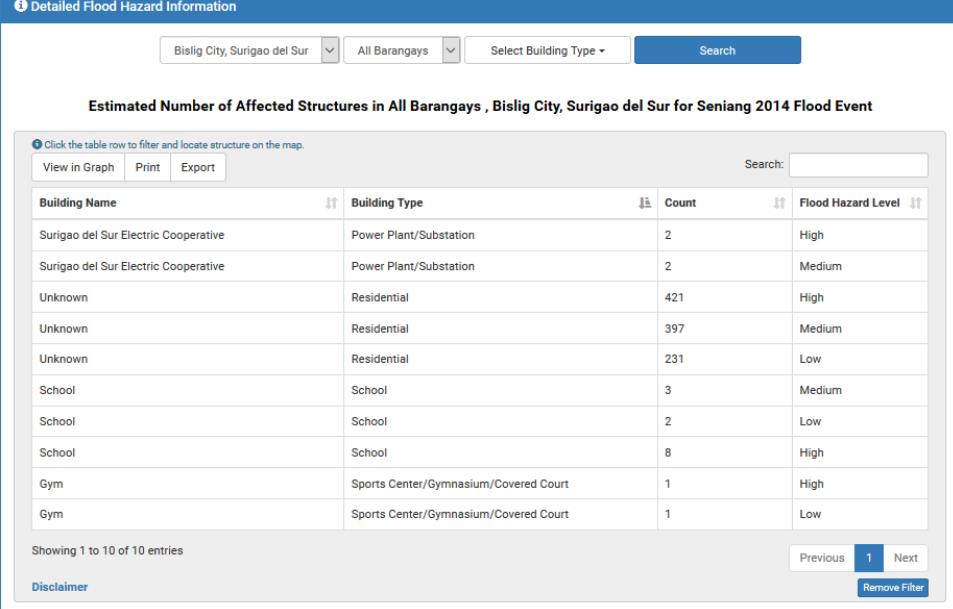
Figure 7. A more detailed information (like the building name of the affected structures) can be displayed in Detailed Flood Hazard Information